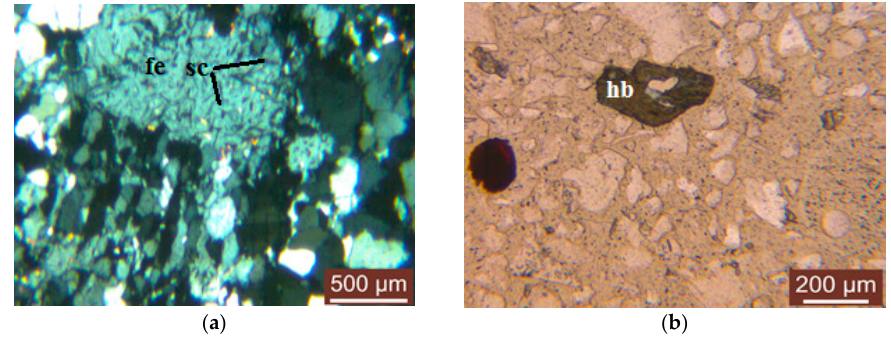
Figure 3. Microscopic images of ( a ) feldspar (fe) and schorlite (sc) and ( b ) hornblende (hb) in the Augen-Gneiss sample.